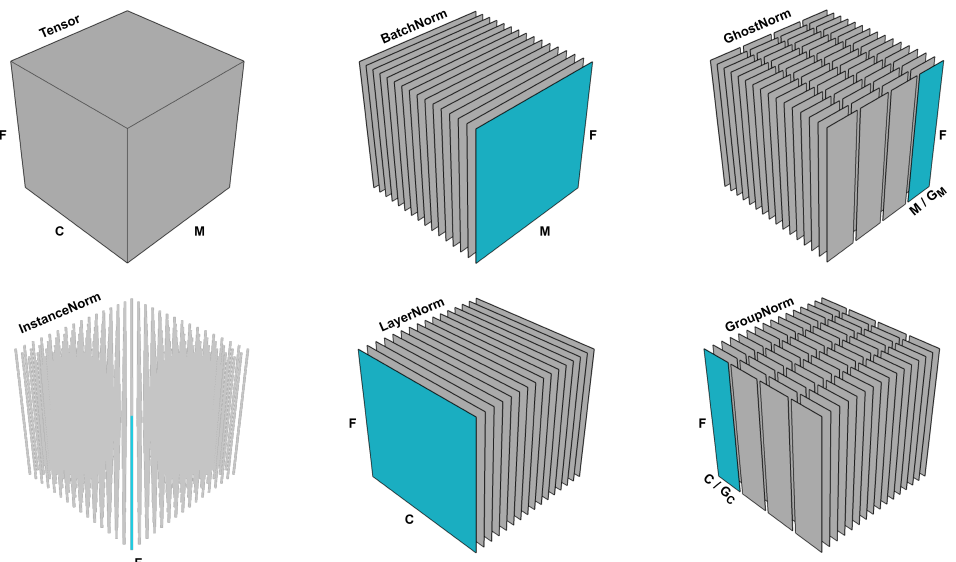
Figure 1. The input tensor with ( M , C , F ) dimensions is divided into a number of line (1D) or plane (2D) slices. Each normalization technique slices the input tensor differently and each slice is normalized independently of the other slices. For ease of visualization, both G C and G M are set to